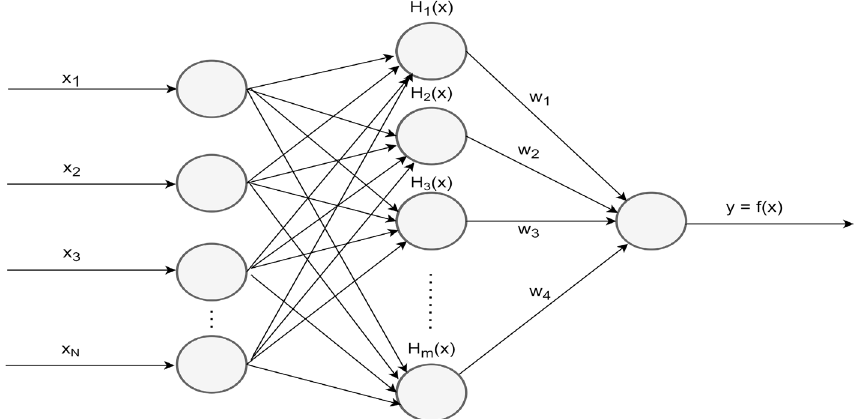
Fig. 7 RBF network. Source :